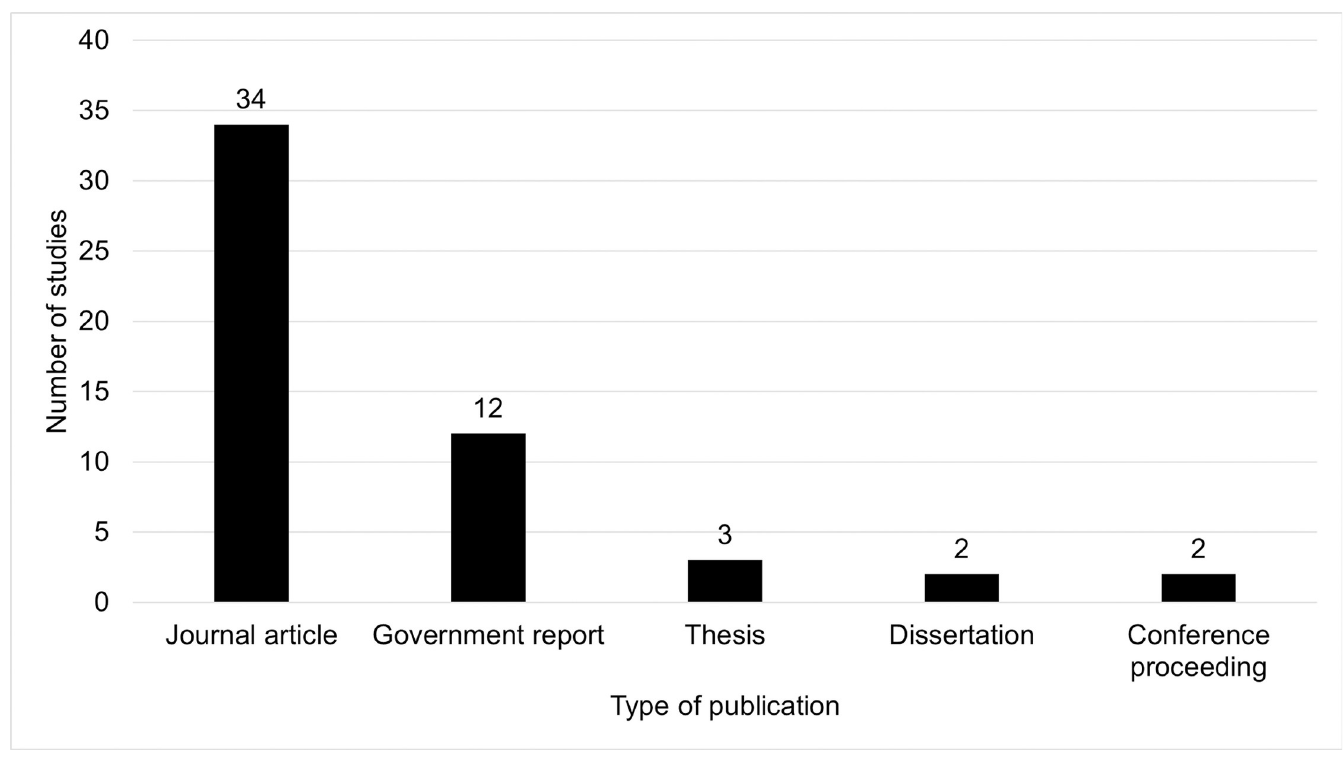
Fig 3. Frequency of publication types.